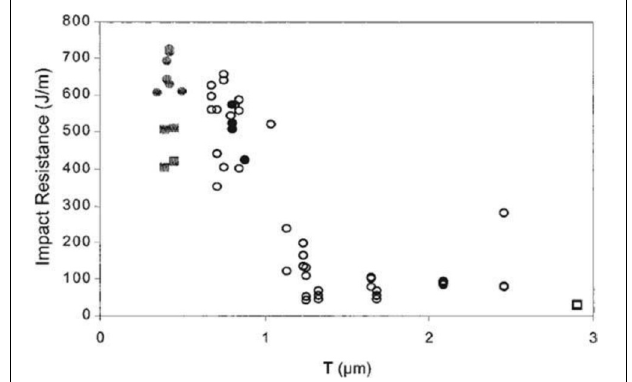
FIGURE 13 | Relationship between matrix ligament thickness (MLT) and impact resistance for: 80:20 PLLA/LLDPE binary blend (open circles); 80:20:5 PLLA/LLDPE/PLLA–PE(5–30) (black circles); 80:20:5 PLLA/LLDPE/PLLA-b-PE(30–30) (gray circles); 80:20 (w/w) PLA/LLDPE binary blend (open squares); and 80:20:5 (w/w) PLA/LLDPE/PLLA-b-PE(30–30) (gray squares). Copyright (2003) Wiley; used with permission from Anderson et al.